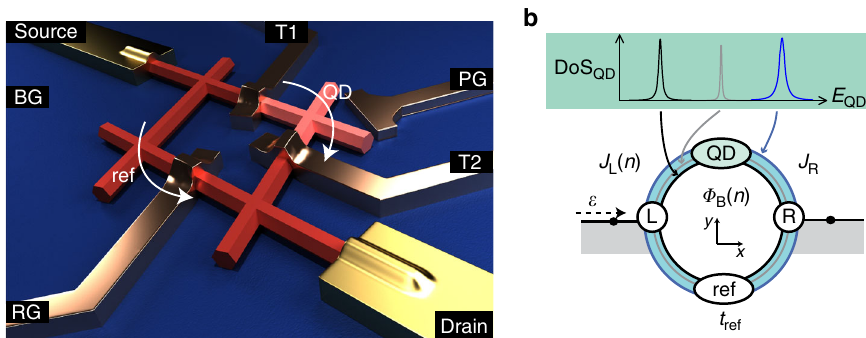
Fig. 6 The multi-path interferometer. a Illustration of the device: in red the nanowire, in gold the leads, in copper the gates and in pink the quantum dot. b Schematic of the device: the quantum dot exhibits a density of states (DoS QD ) comprised of discrete levels with distinct energy broadening. In the model, we assume that the dot states might couple to different interferometer trajectories that are sketched as rings of